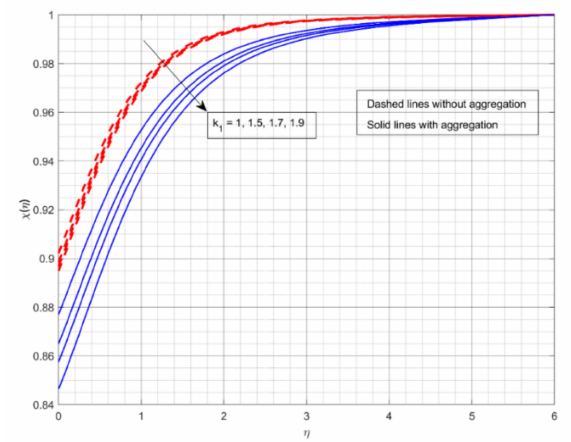
Figure 8. The impact of strength of heterogeneous reaction parameter on the concentration pro- file χ ( η ) .